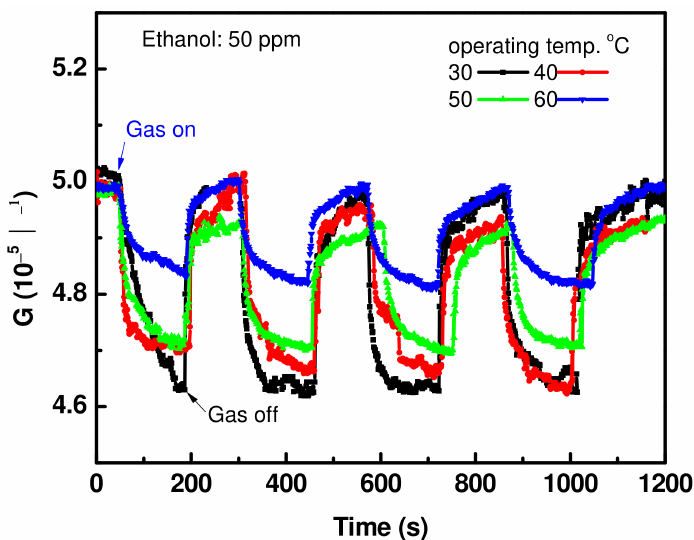
Figure 9. Cyclic curve of sensor signals at concentrations of 50 ppm, and various temperatures for the sensor fabricated with CNTs/24 nm-Ni layer.